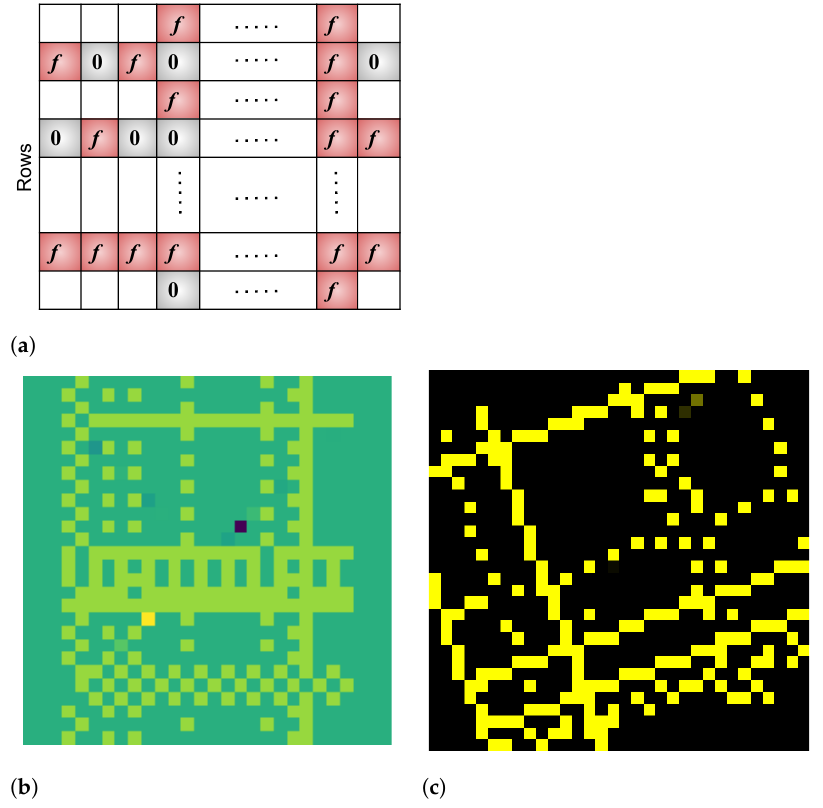
Figure 6. Generation of structured patterns and examples. ( a ) Structured pattern constructed by repeating the [ 0, f ] , [ f ,0 ] , [ f , f ] primitive patterns. ( b , c ) Example of a structured